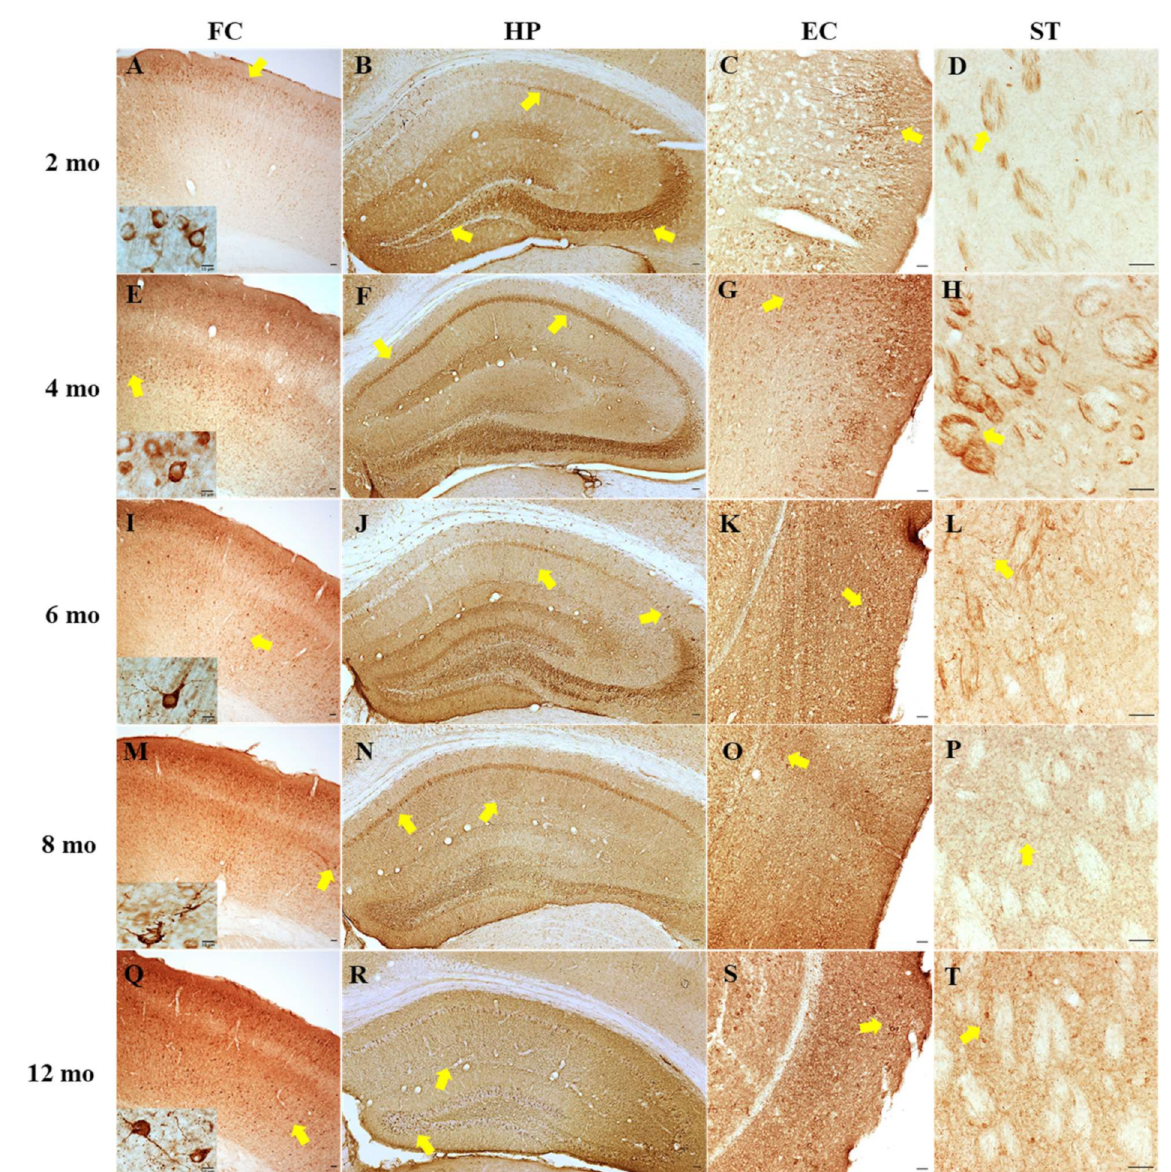
Figure 8. Immunohistochemistry with the AT8 antibody showing phosphorylated tau (Ser202/Thr205) in the frontal cortex (FC; A , E , I , M , Q ), hippocampus (HP; B , F , J , N , R ), entorhinal cortex (EC; C , G , K , O , S ) and striatum (ST; D , H , L , P , T ) of PS19 mice at 2 ( A – D ), 4 ( E – H ), 6 ( I – L ), 8 ( M – P ) and 12 ( Q – T ) months of age. Scale bars: 50 µ m for each